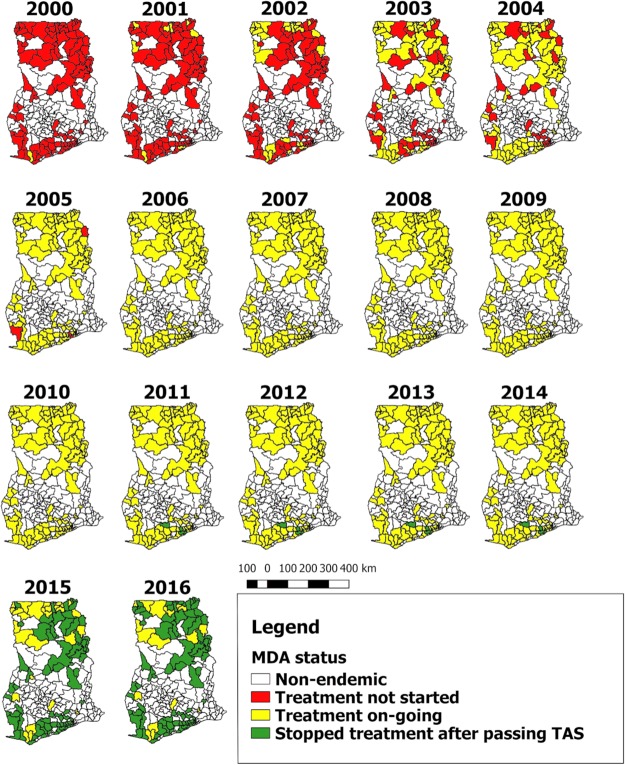
Progress of MDA implementation in Ghana by district.NB: In the year 2011, there was no treatment due to some logistical challenges. The maps give an overview of the treatment progression to cover all the endemic districts in Ghana.